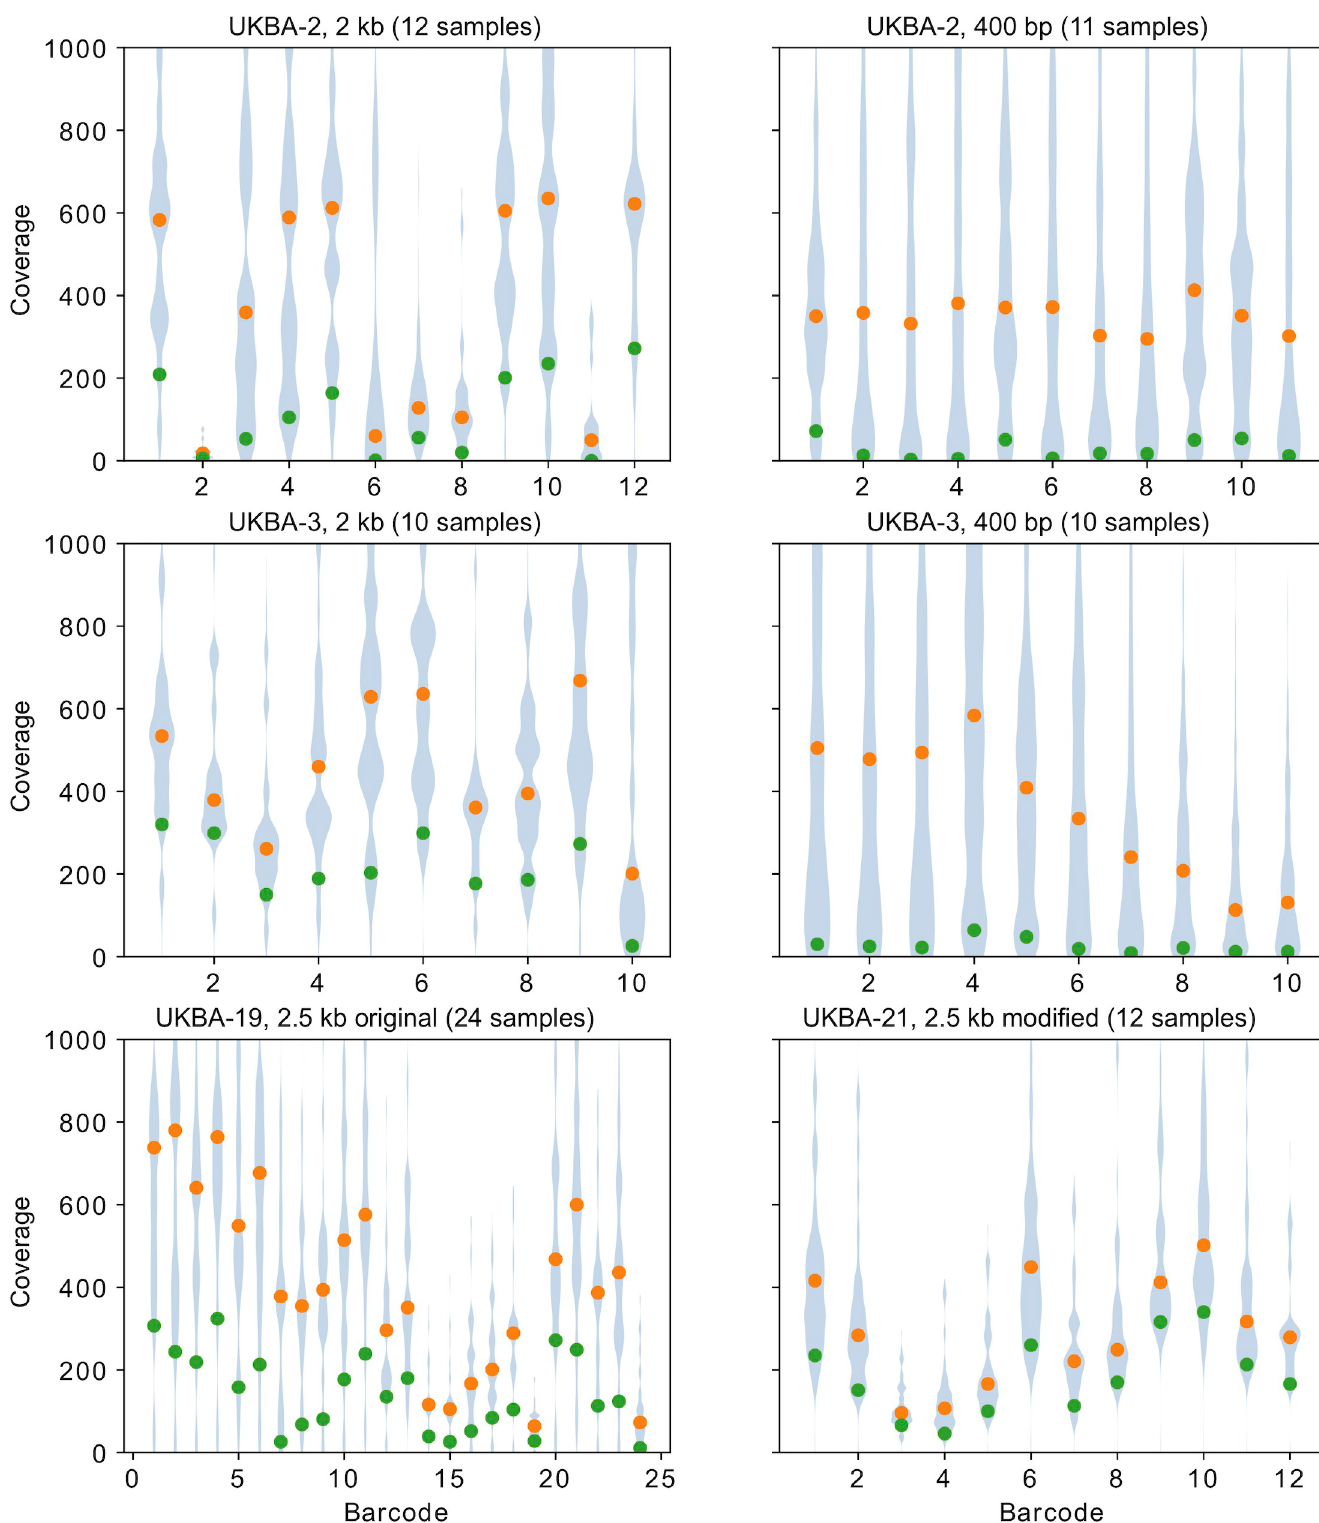
Fig 5. Coverage distribution in different sequencing runs. For each barcode, coverage by reads passing the Artic filter was computed along the genome (shown in Fig 4 and S2 Fig ) and the distribution of the coverage values was summarized as a violin plot (blue), cropped at coverage 1000. Orange dots represent median coverage